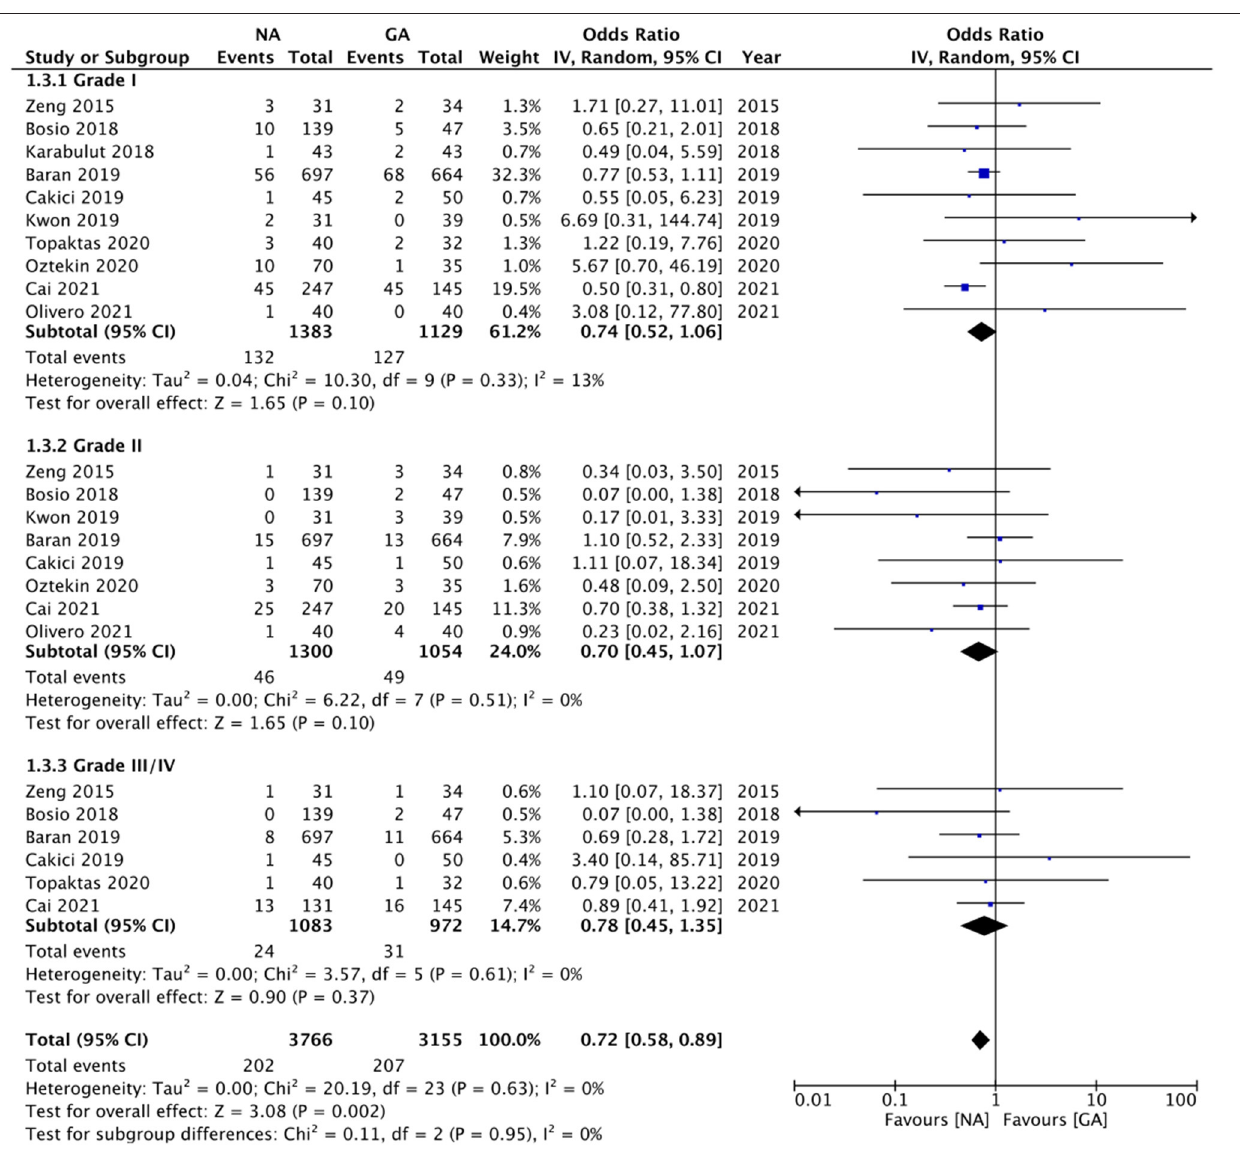
FIGURE 5 | Meta-analysis of complication rates between NA and GA for RIRS.